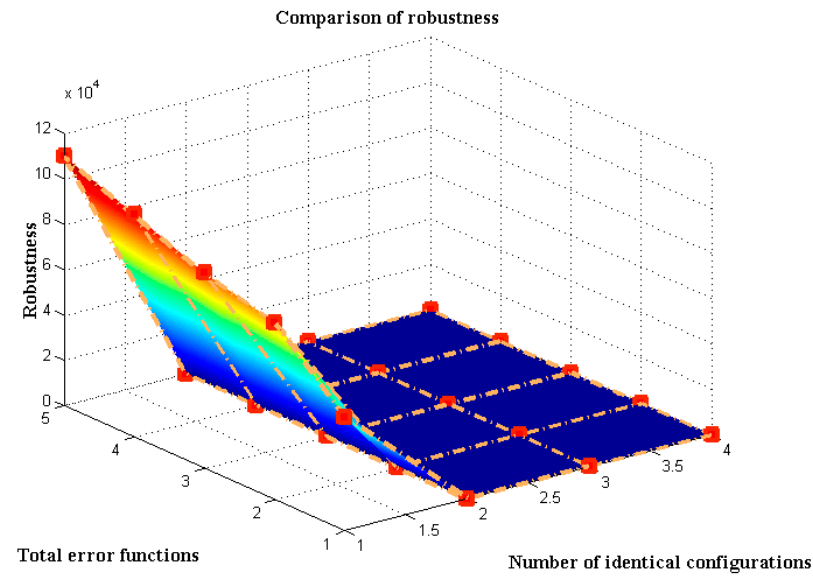
Figure 3. Robustness with error functions.